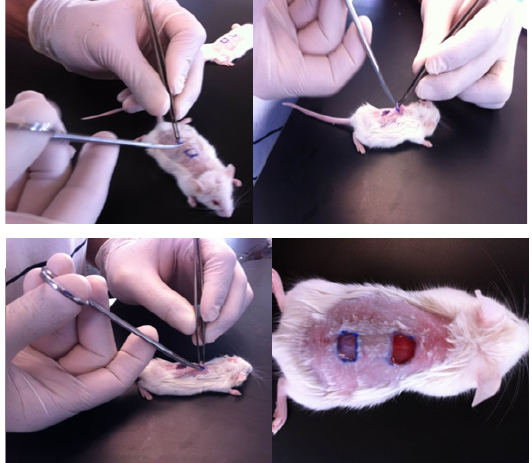
Figure 1. Surgery process. The lesion nearby the head was implanted with nanocomposites or TheraForm ® as a positive control, and the location near the tail was an untreated wound as a basal control for wound healing.